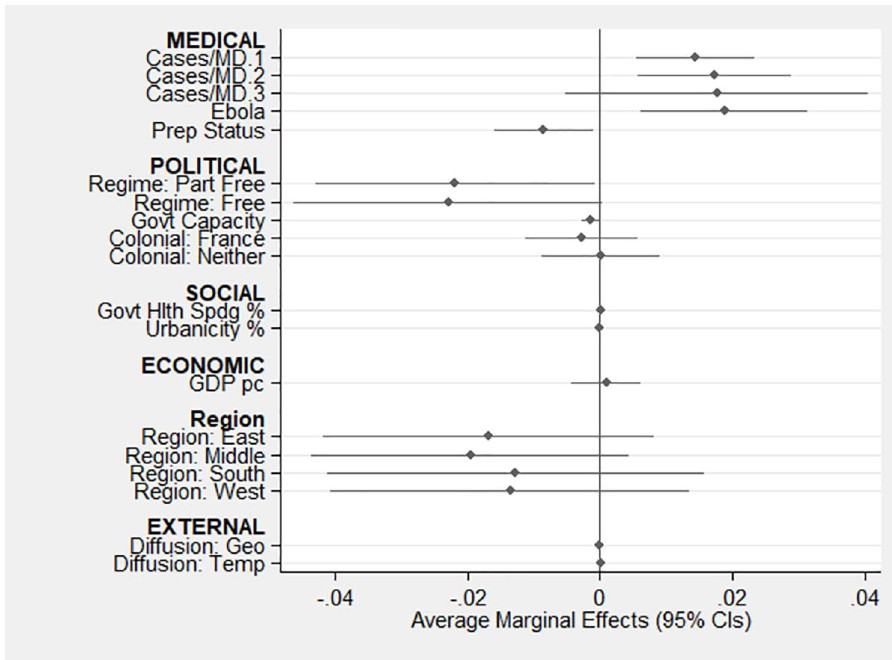
Fig 2. Average marginal effects derived from Model 1. NOTE: Temporal diffusion is statistically significant (p < 0.001), but the effect is not discernible in this